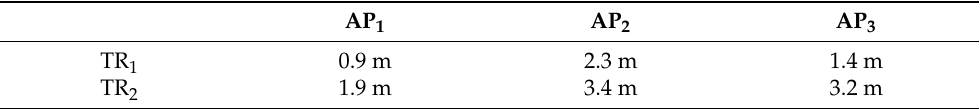
Table 2. Thresholds of HA LP , MA LP , and BP.